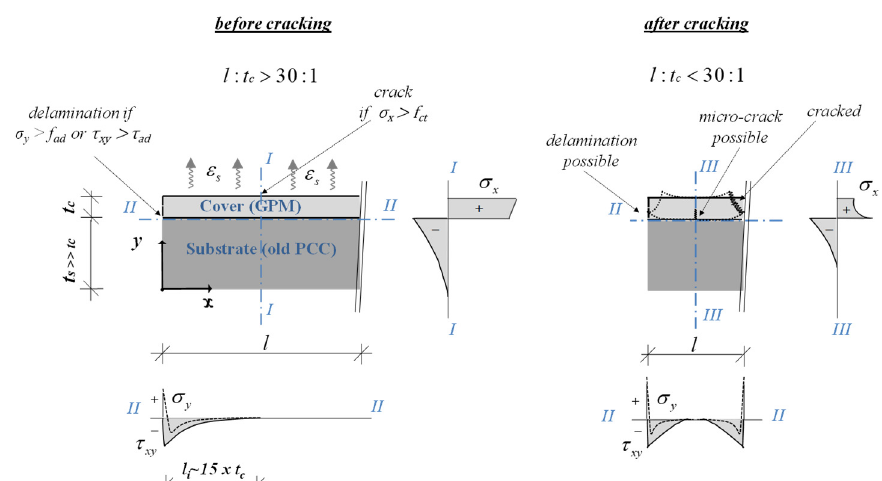
Figure 1. Stress distribution of enforcements ( σ x , σ y , τ xy ) due to constrained hygric shrinkage ( ε s ) depending on ratio l: t c (extent : cover layer ‐ thickness) of a GPM ‐ PCC composite body. With: f ct …tensile strength, f ad …tensile adhesion strength, τ ad …shear adhesion strength of cover, l i …initiation length, modified after